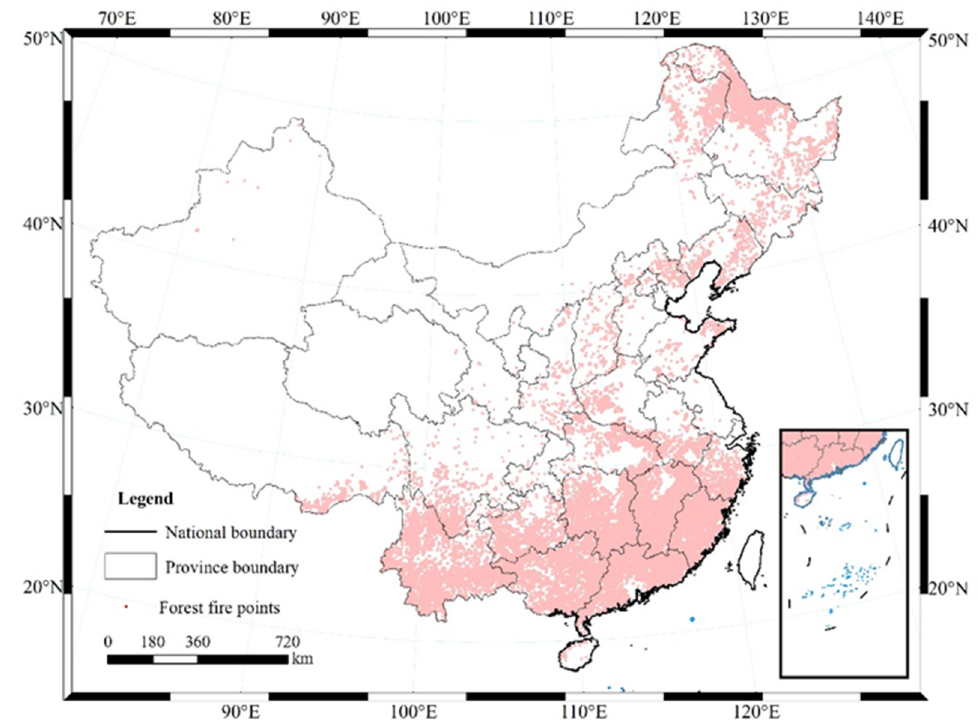
Figure 1. Study area (data not available for Hong Kong, Macao, and Taiwan).